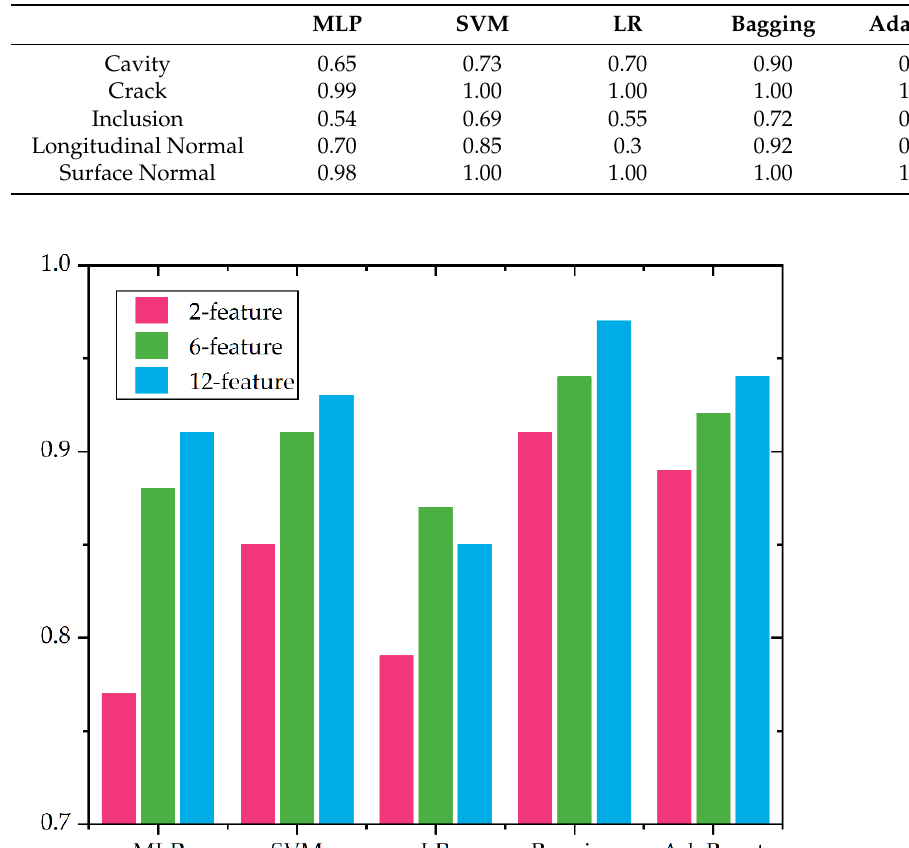
Figure 11. The average accuracy of different algorithms on the identification of different defect types of aero ‐ engine blades.